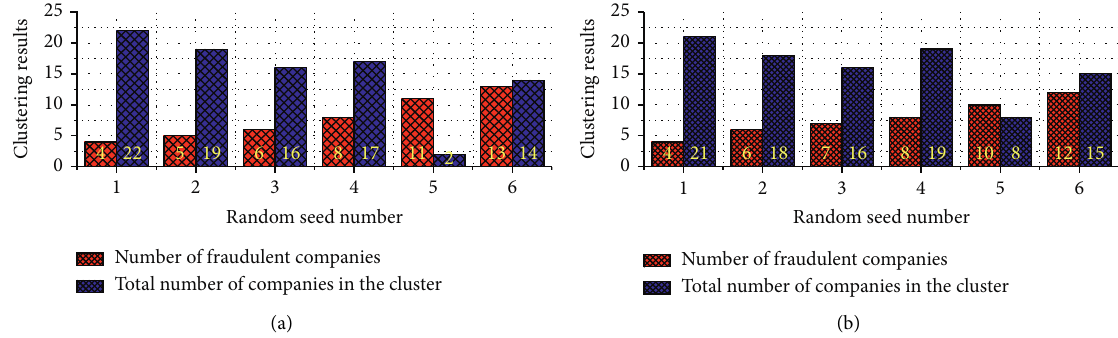
Figure 3: Cluster classification results. (a) Two cluster target classification numbers. (b) Three cluster target classification numbers.